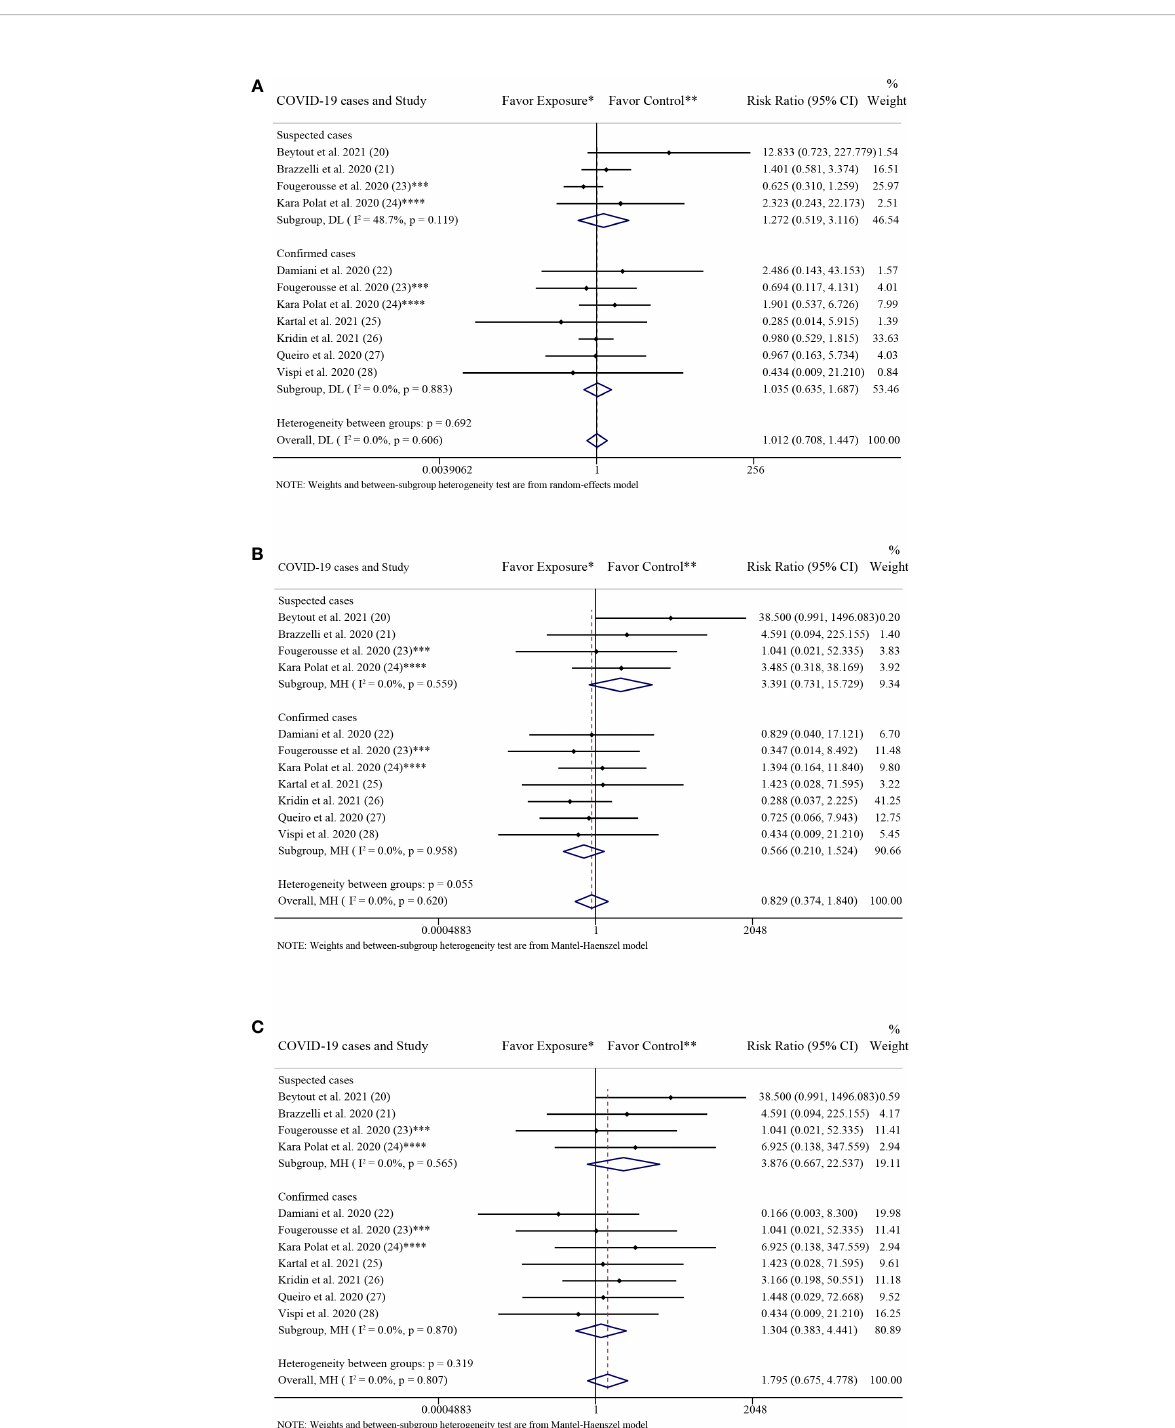
FIGURE 5 Subgroup analysis grouped by COVID-19 cases. (A) Forest plot of risk ratios and 95% CIs of the SARS-CoV-2 infection rate; (B) Forest plot of risk ratios and 95% CIs of the COVID-19 hospitalization rate; (C) Forest plot of risk ratios and 95% CIs of the COVID-19 mortality rate. CI , con fi dence interval; COVID-19 , coronavirus disease 2019; DL , DerSimonian-Laird estimate of tau 2 ; NA , not available. *Exposure represents patients with psoriasis treated with IL-17 inhibitors. **Control represents patients with psoriasis treated with non-biologics. ***In the exposure group, there were 14 COVID-19 cases, including 2 con fi rmed cases and 12 suspected cases. And in the control group, there were 23 COVID-19 cases, including 3 con fi rmed cases (1 hospitalized with COVID-19) and 20 suspected cases. ****In the exposure group, there were 5 COVID-19 cases, including 3 con fi rmed cases, 1 suspected cases and 1 sample not gone. And in the control group, there were 14 COVID-19 cases, including 11 con fi rmed cases (5 hospitalized with COVID-19) and 3 suspected cases (2 hospitalized with